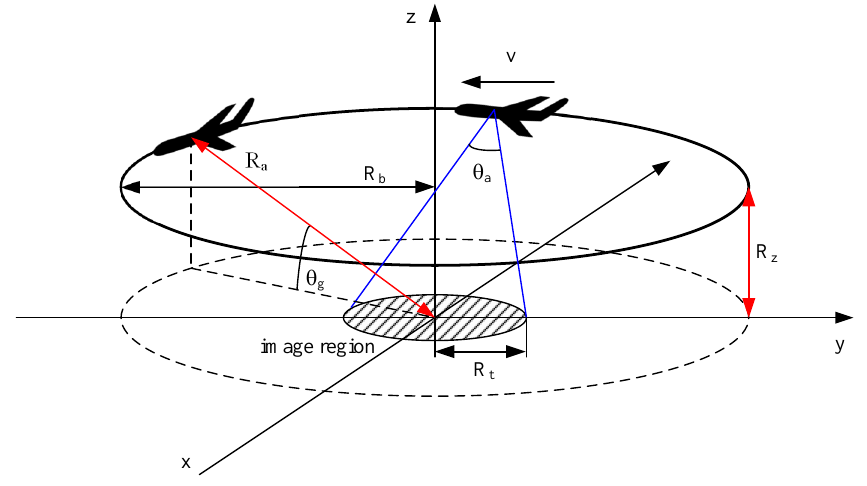
Figure 6. Collection geometry of video SAR on a circular